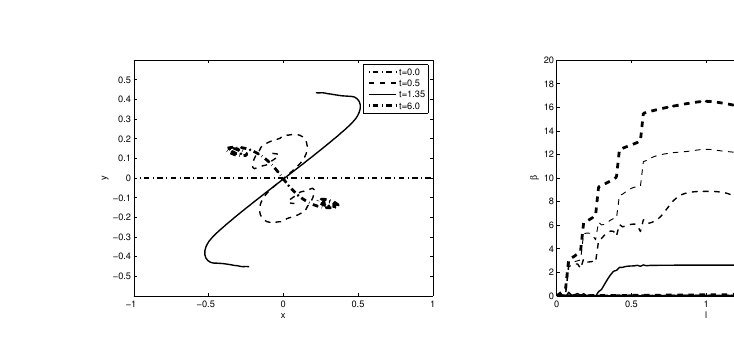
Figure 24. Droplet reverse dynamics at ωτ = 24 ⇒ 0, t f = 6.